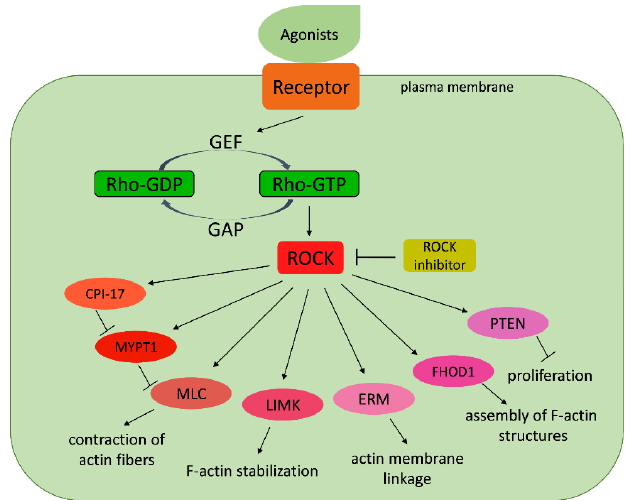
Figure 13. Simplified representation of the Rho/ROCK signaling pathway. GEF—guanine nucleotide exchange factor; GAP—GTPase activating protein; Rho—Ras homolog family member (activated if linked to GTP); ROCK—Rho-associated coiled-coil containing protein kinase; CPI-17—protein phosphatase 1 regulatory inhibitor subunit 14A; MYPT1—myosin phosphatase target subunit 1; MLC—myosin light-chain kinase; LIMK—LIM domain kinase; ERM—acronym from ezrin, radixin, moesin proteins; FHOD1—formin homology 2 domain containing 1; PTEN—phosphatase and tensin homolog.